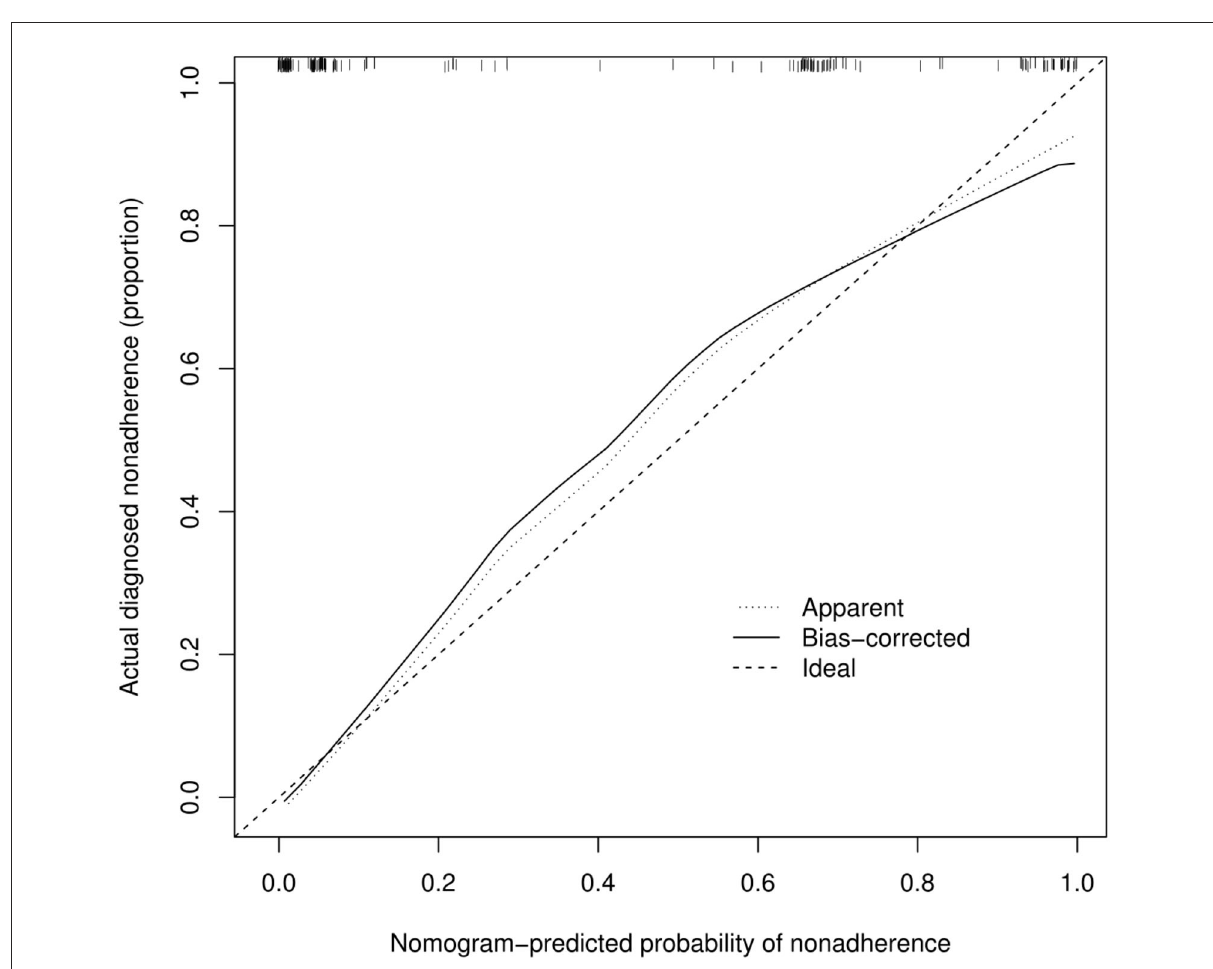
FIGURE2 Predictive model based on logistic analysis for early diagnosis of AF in stroke in development and validation